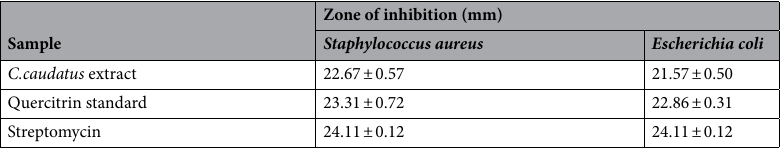
Table 6. Antimicrobial activity of C. caudatus leaves extract.